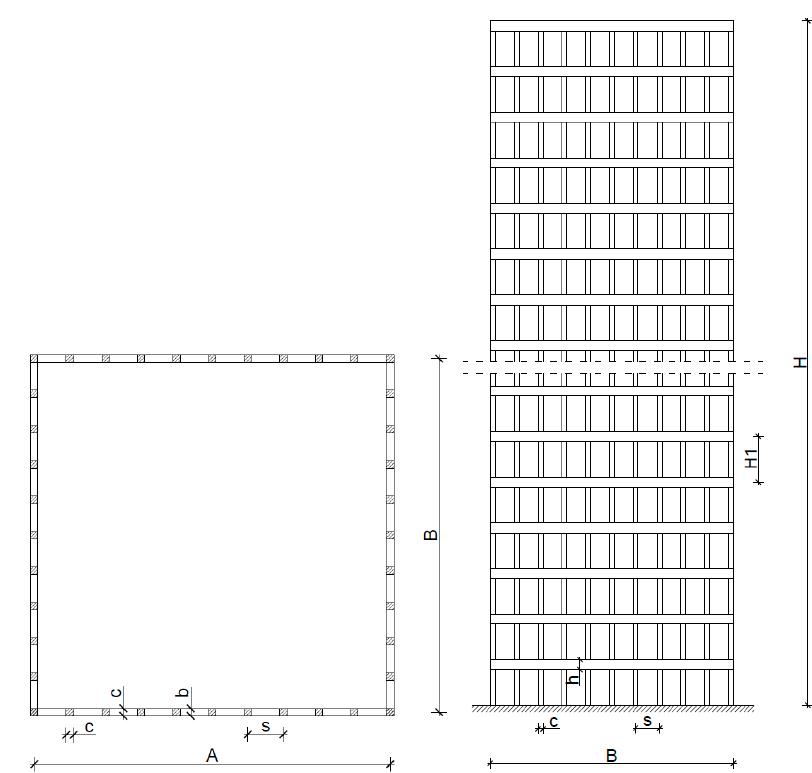
Figure 4. Layout of the building dimensions and the dimensions of structural elements.